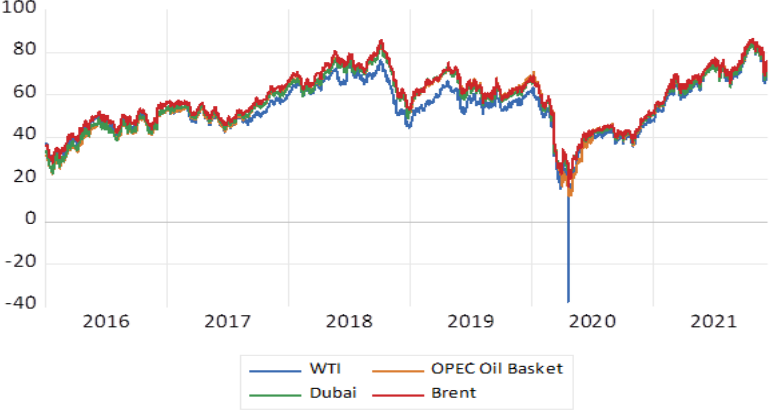
Figure 1. Oil Prices. Note: WTI recorded a historically low price of − 36$ in April 2020. Source: Datastream 2022.